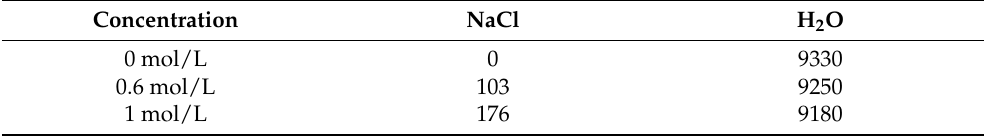
Table 1. Number of water molecules and NaCl in the solution with different concentrations.